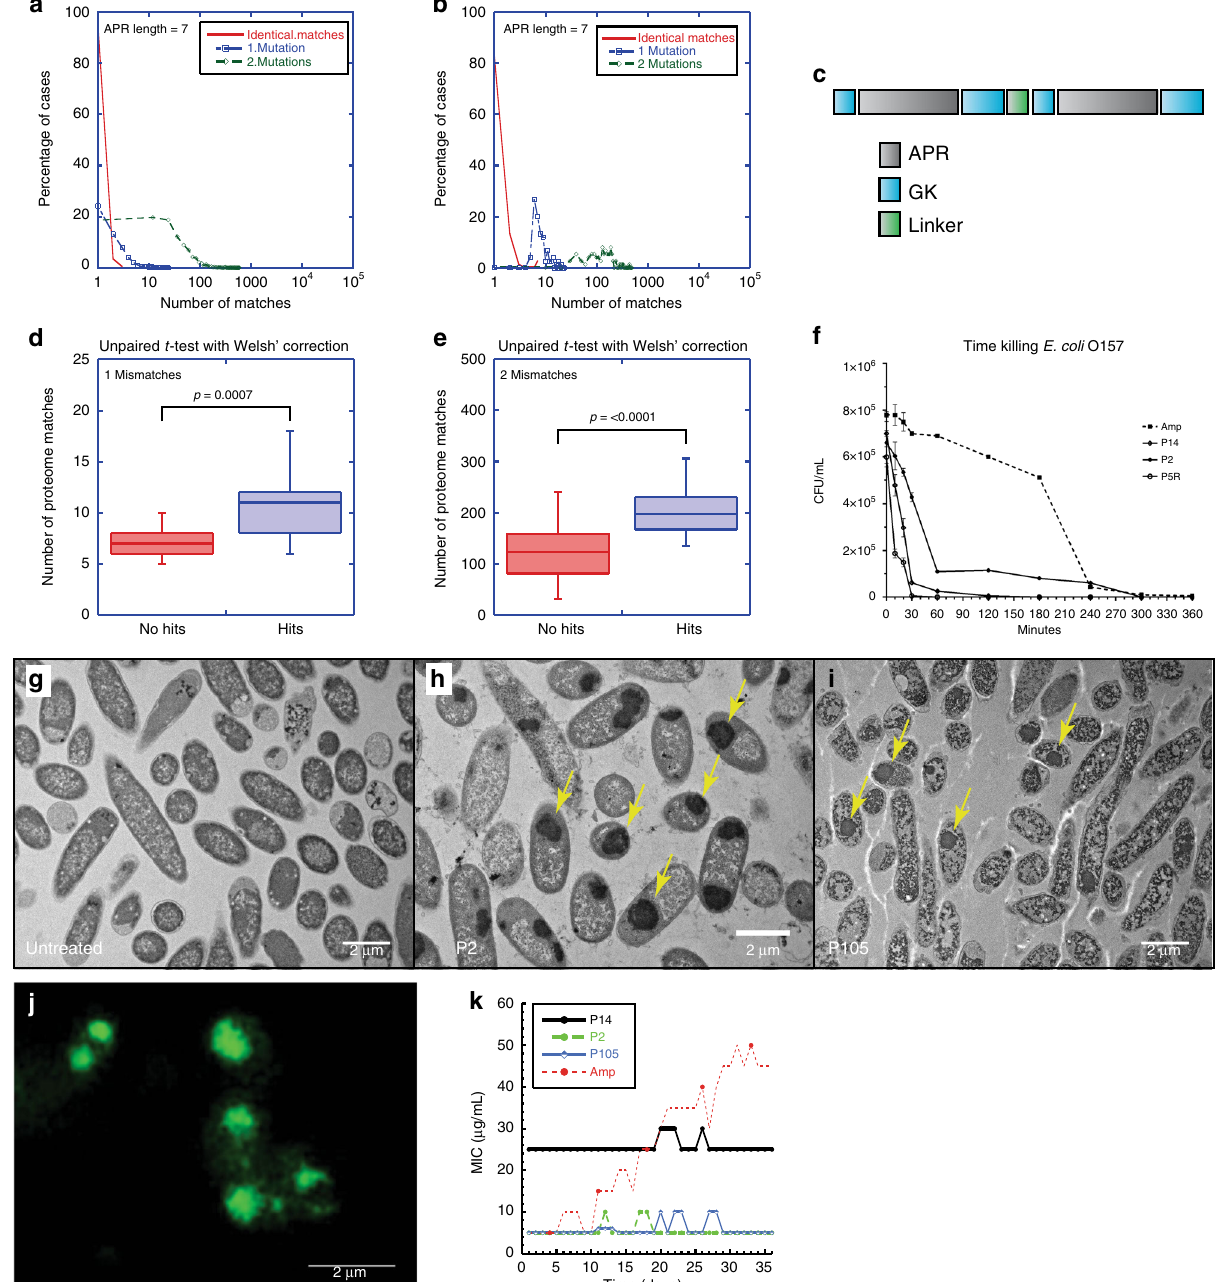
Fig. 1 Proteome analysis, design, and screening of redundant APRs. a Distribution of the redundancy of APR sequences of length seven in the E . coli proteome: percentage of identical sequences (red), one mismatch (blue), and two mismatches (green). b Same distribution as in a for the 75 most redundant APRs in E . coli . c Design pattern for aggregating peptide screen. Tandem APRs are linked by a linker (a single proline residue) and embedded between gatekeeper residues (GK; arginine residues). d , e APR redundancy for toxic versus nontoxic peptides considering one ( d ) or two ( e ) mismatches. The bottom and top of the boxes are the fi rst and third quartiles, and the band inside the box represents the median. The whiskers encompass the minimum and maximum of the data. Signi fi cant differences were computed using Welch ’ s t test. f Time-killing curve of selected peptides (P14, P2, and P5R) and ampicillin (Amp) against E . coli strain O157:H7 treated at MIC concentration (average and SD of three replicates). g – i Transmission electron microcopy (TEM) of cross-sections of resin-embedded E . coli O157:H7, treated for 2 h with buffer ( g ), P2 peptide ( h ), and P105 peptide ( i ) at MIC concentration. j Wide- fi eld structured illumination microscopy (SIM) image of E . coli O157:H7 treated with P2 and stained with the amyloid-speci fi c dye pFTAA (0.5 µ M). k Monitoring of spontaneous buildup of resistance by monitoring the MIC value of E . coli O157: H7 cultures that are maintained on sublethal doses (50% of MIC) of selected peptides (P14, P2, and P105) or ampicillin (Amp) for 36